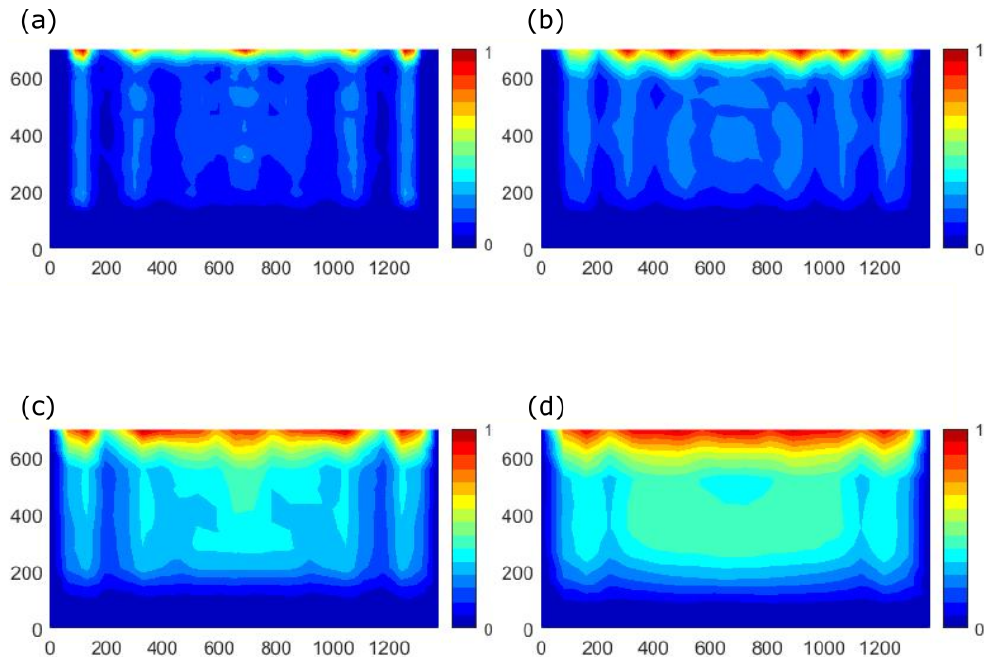
Figure 14. Figures showing normalized and mirror averaged wear maps for mesh edge lengths, ( a ) 30 mm, ( b ) 45 mm, ( c ) 60 mm, and ( d ) 75 mm. The particle size distribution is the baseline with smallest particles with radius, R = 100 mm. Color plots are showing the normalized wear depth in mm.